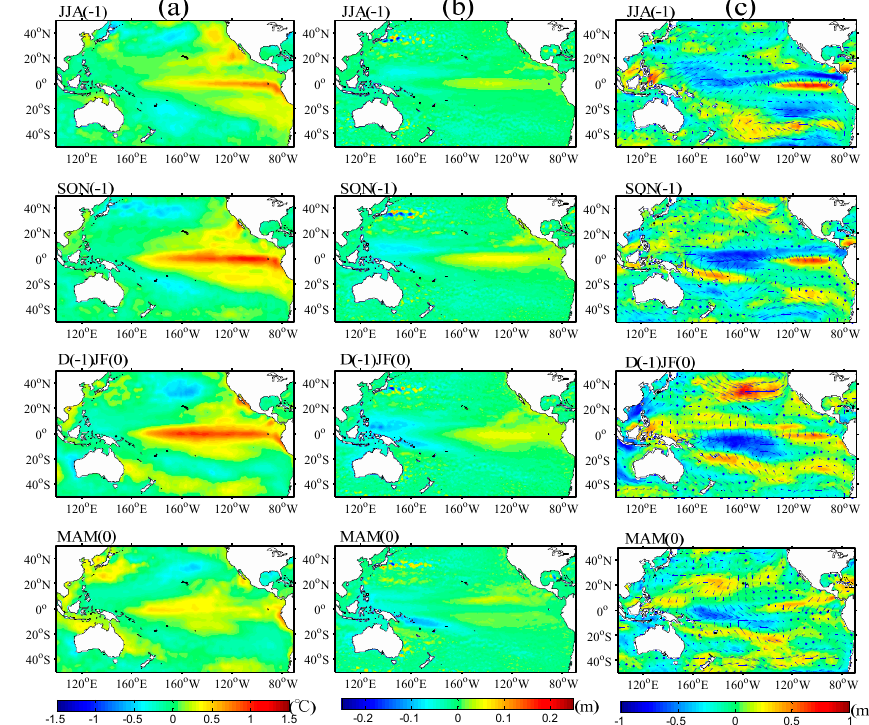
Figure 7. Seasonally evolving patterns of ( a ) SST; ( b ) sea level; and ( c ) SSW anomalies from one year prior to precipitation, i.e., JJA( − 1) to MAM(0), regressed with the PC of the second SEOF mode of precipitation.